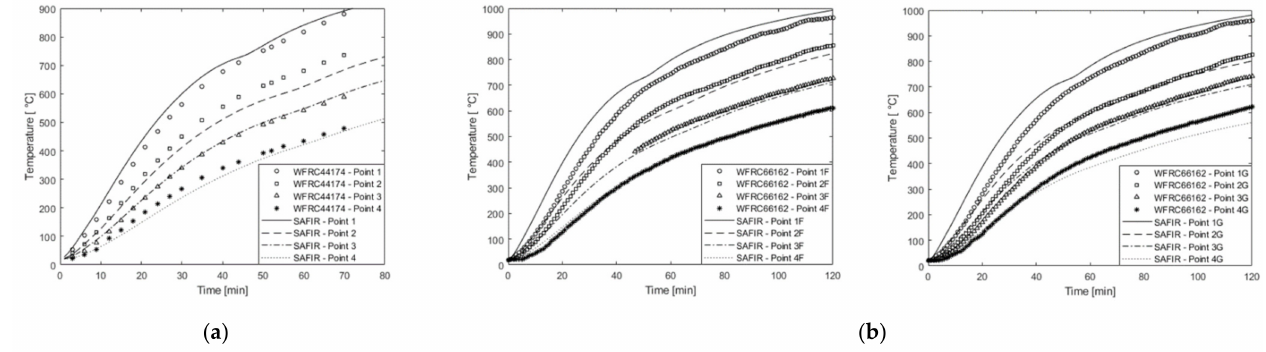
Figure 7. Temperature comparison between the numerical model and the experiment for: ( a ) WFRC 44174; ( b ) WFRC 66162 [28].